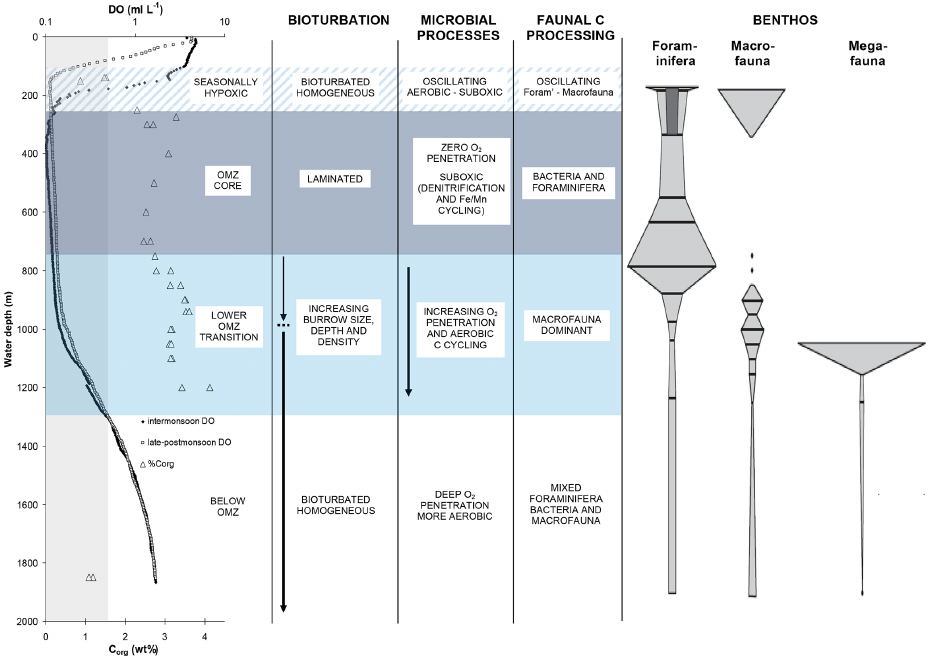
Figure 11. A summary of water-column conditions, sediment properties, benthic communities, and processes influencing carbon cycling across the OMZ on the Indus margin of the Arabian Sea (modified from Cowie and Levin, 2009, and reprinted with the permission of Elsevier). Water-column dissolved oxygen (DO) concentration profiles are shown for intermonsoon (April–May) and late-to-postmonsoon (September–October) periods. Organic carbon (C org ) concentrations (weight percent) are for surficial (0–2cm) sediments. The vertical shaded zone indicates OMZ boundaries as defined by DO ≤ 0.5mLL − 1 . Shaded depth ranges denote the OMZ core ( ∼ 250–750m, near- uniform DO of ≤ 0.1mLL − 1 ), a lower OMZ transition zone ( ∼ 750–1300m) in which DO and the numbers of and activity of macrofauna increase with station depth, and a seasonally hypoxic zone ( ∼ 100–250m) in which the upper OMZ boundary shoals during the summer monsoon season. Faunal classes are as defined by Gooday et al.